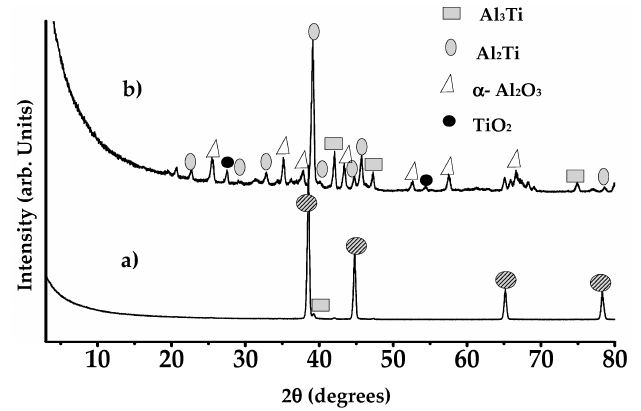
Figure 5. TF ‐ XRD of Al layer on the Ti alloy after heat treatment at 640 °C for 12 h ( a ) and subsequent heat treatment at 850 °C for 96 h ( b ) both in an air atmosphere. Reproduced from [100] with permission from Trans Tech.